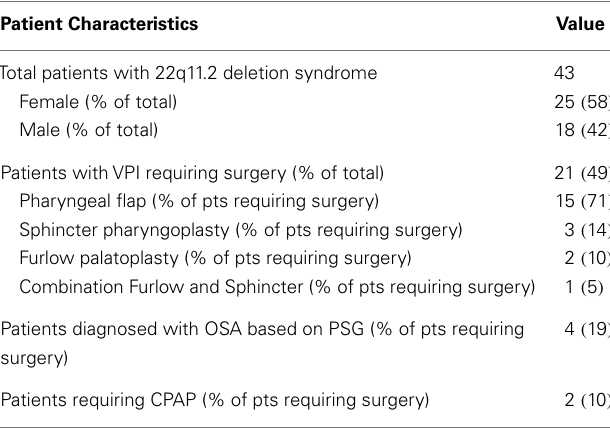
Table 1 | Patient characteristics of those included in the study with the corresponding values